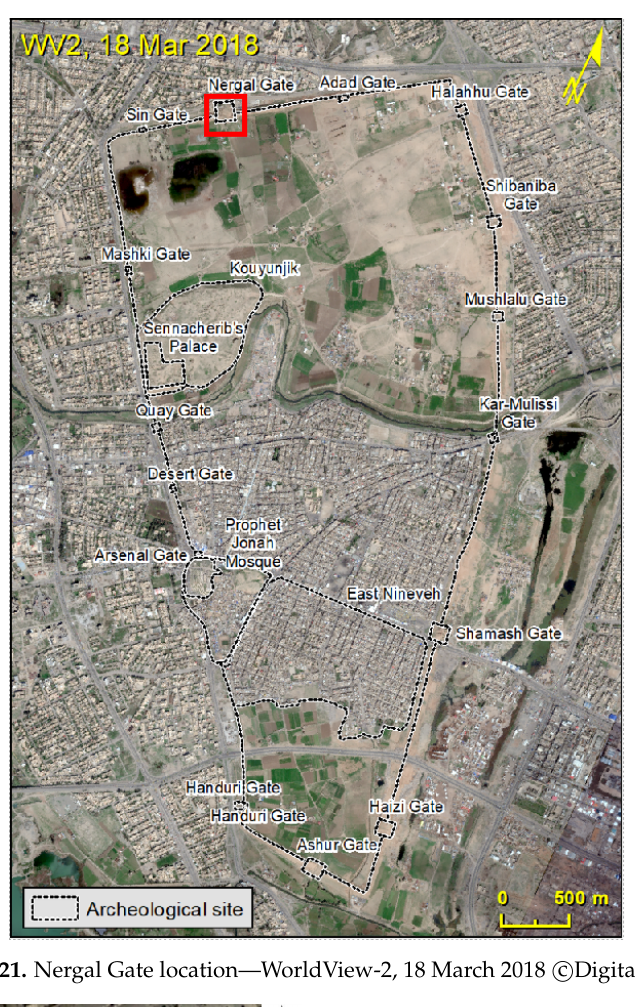
Figure 21. Nergal Gate location—WorldView-2, 18 March 2018 c (cid:13) DigitalGlobe.